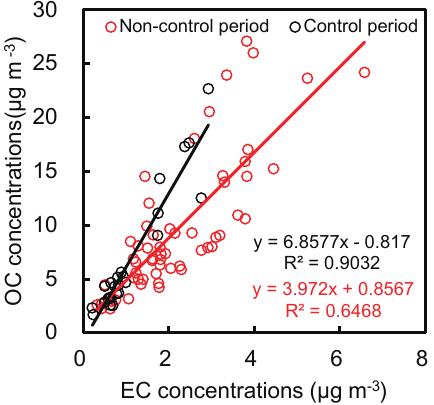
Figure 3. Scatter plot and correlations between organic carbon (OC: y axis) and elemental carbon (EC: x axis) concentrations of PM 2 . 5 during the APEC 2014 and Victory Parade 2015 campaigns. The red symbols denote the non-control period and the black symbols denote the pollution control period. The linear regression equations and R 2 values are given for these two